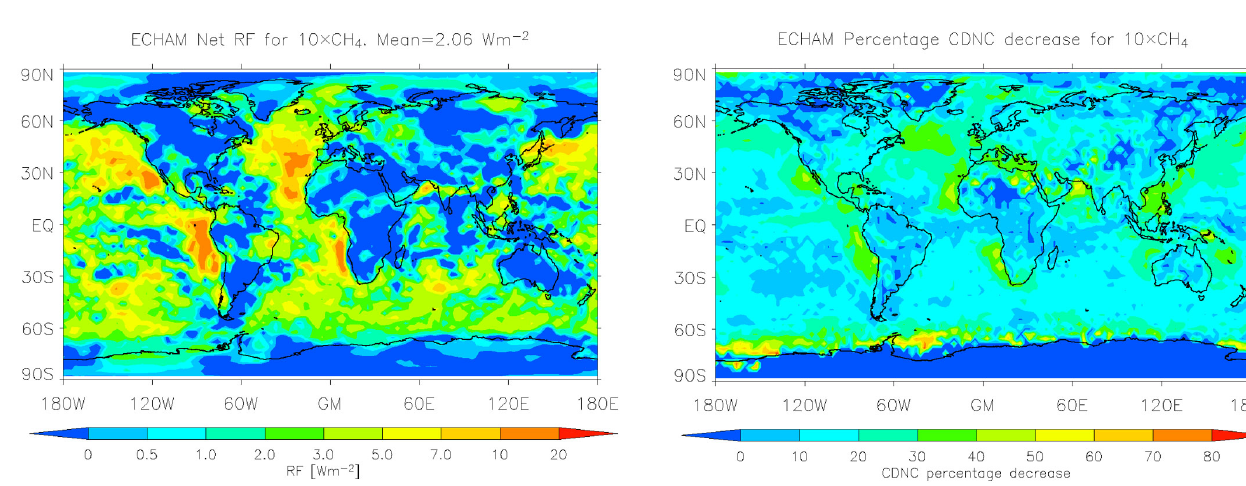
Fig. 3. Predicted percentage decrease in cloud droplet number con- centration (CDNC) when the CH 4 concentration is increased by a factor of 10, using ECHAM5-HAM.